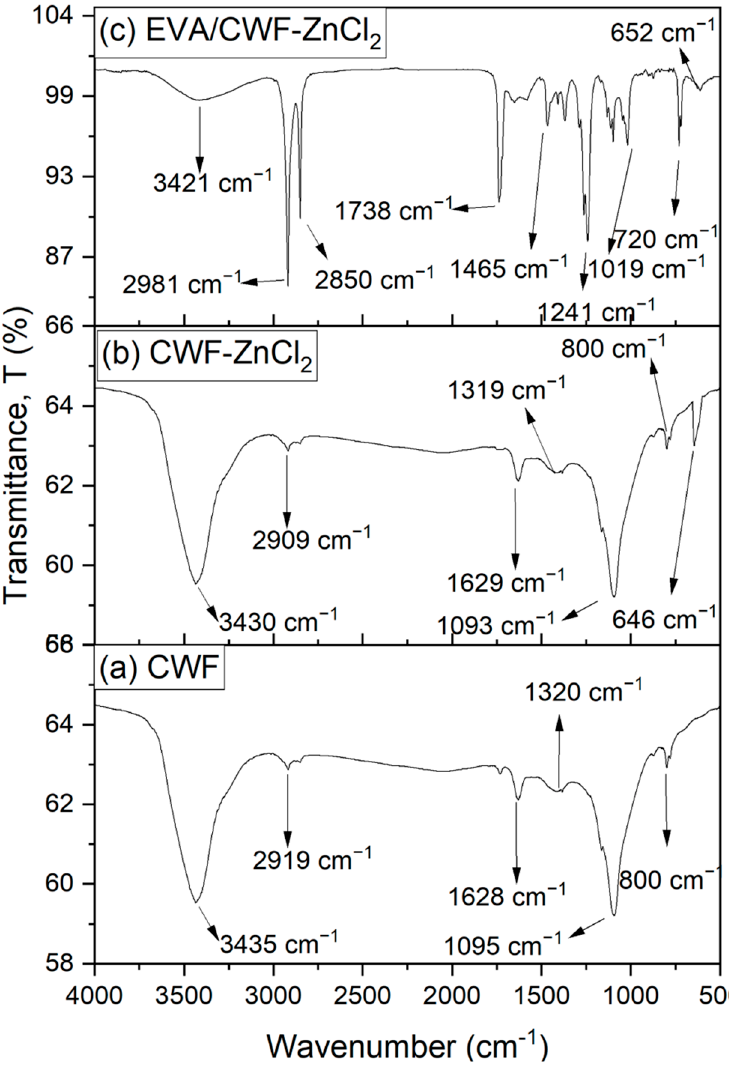
Figure 7. Infrared spectroscopy spectrum of ( a ) CWF filler, ( b ) CWF-ZnCl 2 filler and ( c ) EVA/CWF- ZnCl 2 composites at 6 wt% of ZnCl 2 content.